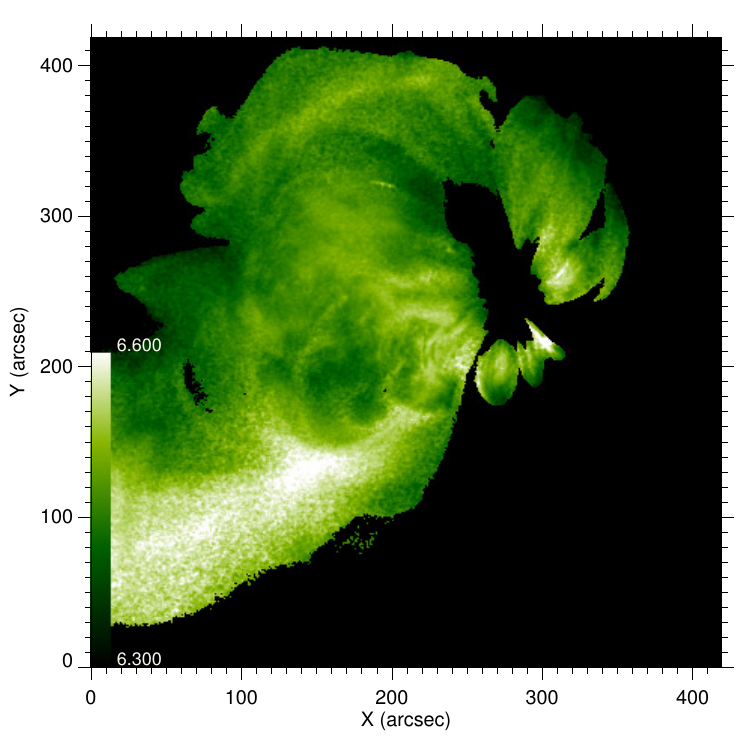
Figure 6: Temperature map of an active region obtained from the ratio of two images in different broadband filters with Hinode/XRT (12 November 2006, 12